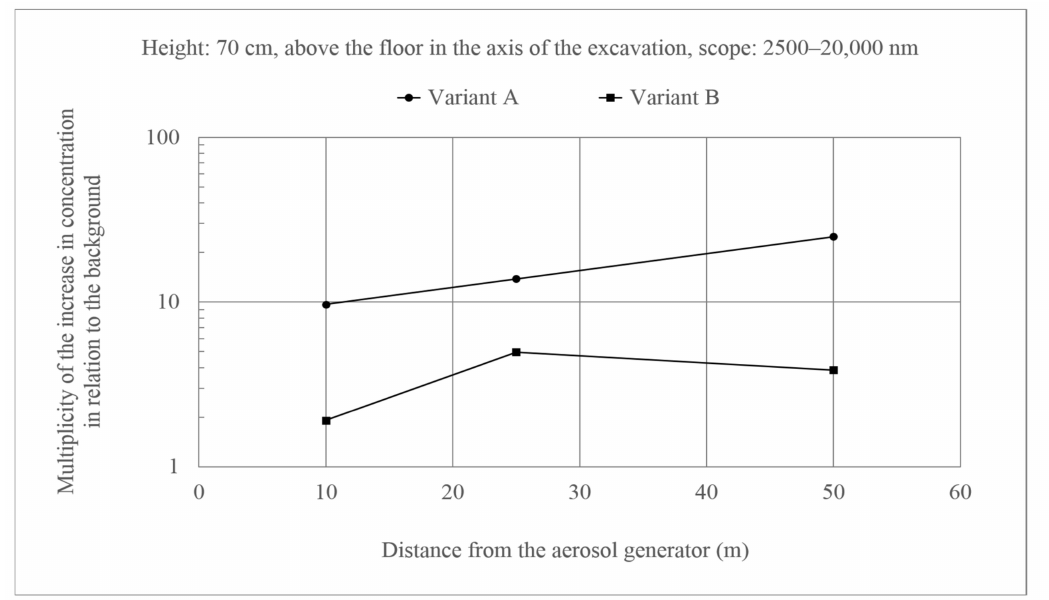
Figure 6. Increase in the concentration of aerosols with a size of 2500–20,000 nm at a height of 70 cm above the floor in the axis of the excavation as compared to the background. Generator capacity: 17 cm 3 of solution/min.